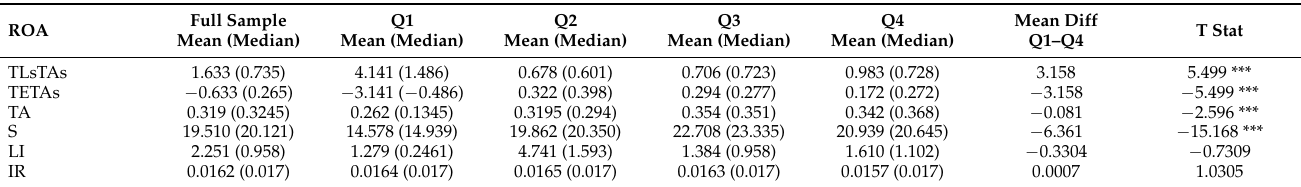
Table 4. Results of TLsTAs, TETAs, TA, S, LI, and IR by the Quartiles of ROA.